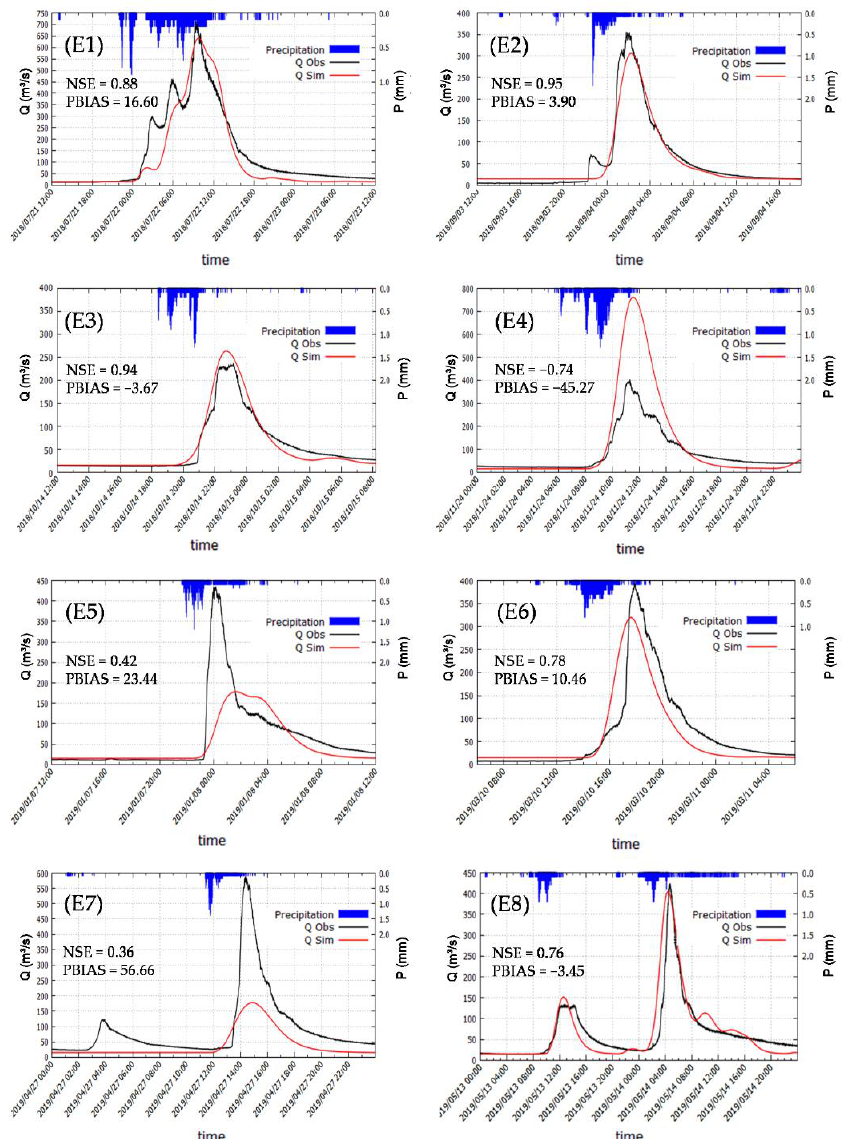
Figure 4. Observed (black line) and simulated (red line) streamflow (m 3 /s) for the calibration and validation events (E1-E8).